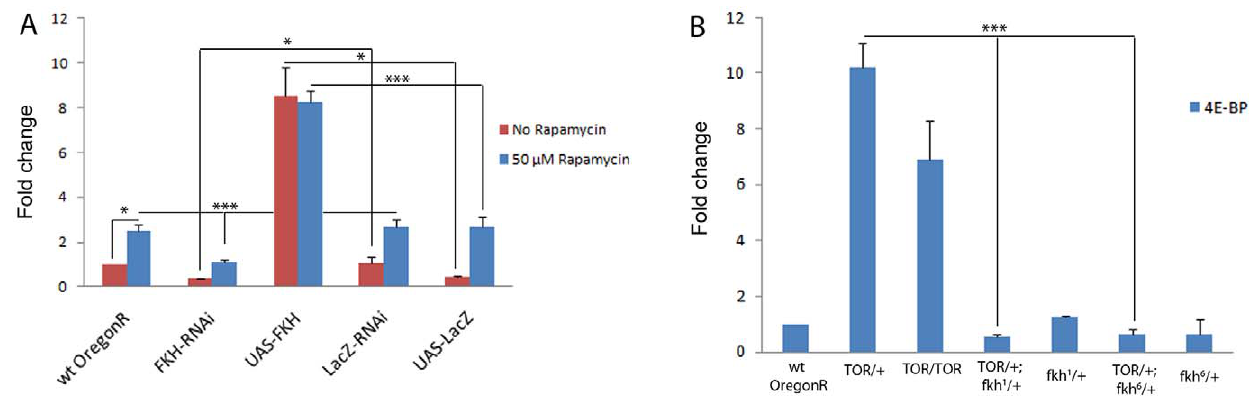
Figure 7. FKH and TOR impact on the expression of the dFOXO target d4E-BP . Realtime qPCR was applied to quantify mRNAs in larval extracts. ( A ) Compared to wildtype and unspecific control animals, transcript levels of d4E-BP are low in larvae expressing FKH dsRNA ( w; arm-Gal4/ + ; UAS-FKH- RNAi/ + ) and high in larvae overexpressing FKH ( w;; ppl-Gal4/UAS-FKH ). d4E-BP is upregulated in larvae treated with rapamycin, and the elevated d4E-BP transcription resultingfrom rapamycin feeding is completely suppressed by FKHRNAi. ( B ) d4E-BP is upregulated in dTOR mutants ( y w; dTOR D P / + andy w ; dTOR D P /dTOR D P ) and the expression is suppressed in larvae transheterozygous for dTOR and FKH mutations ( y w; dTOR D P / + ; fkh 1 / + and y w ; dTOR D P / + ; fkh 6 / + ). This suggests that d4E-BP is a transcriptional target not only of the insulin pathway and dFOXO, but also of the TOR pathway and FKH.